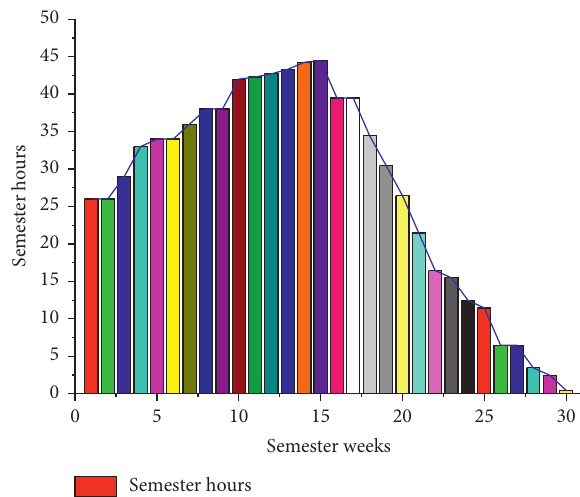
Figure 2: The weekly distribution of class hours is